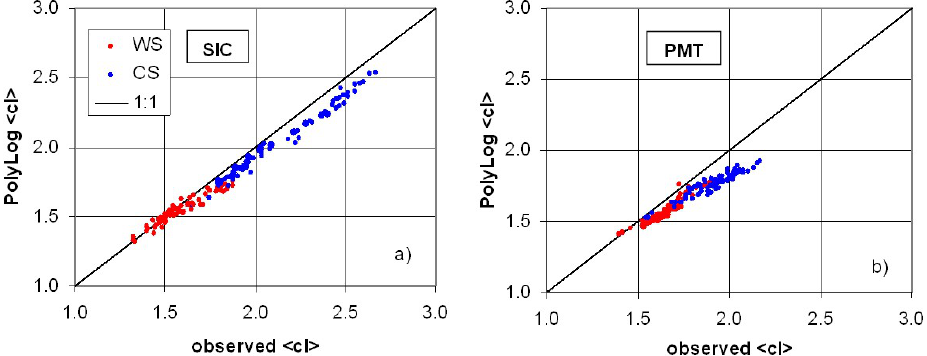
Figure 4. Comparison between observed and estimated average cluster size h cl i for the Mediterranean (SIC, panel a ) and sub-Alpine (PMT, panel b ) areas in both cold (CS) and warm (WS)